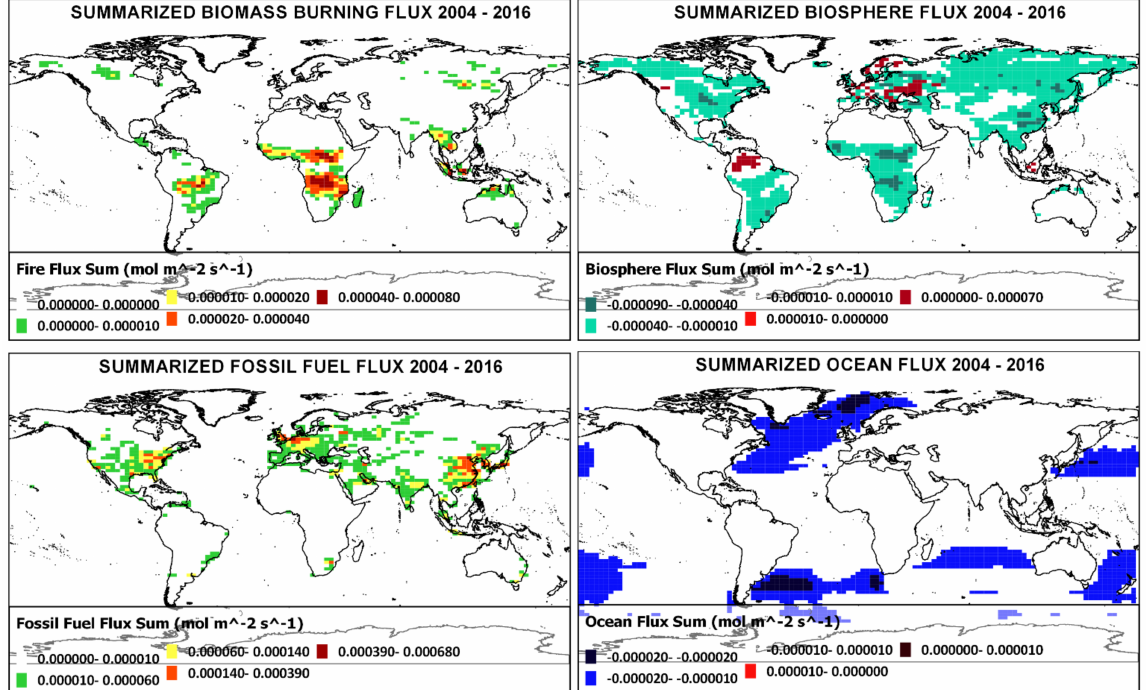
Figure 11. Summarized fluxes from CT (top plots from left to right: biomass burning and biosphere flux representations; bottom plots from left to right: fossil fuel CO 2 emissions, ocean) in the modeled period of